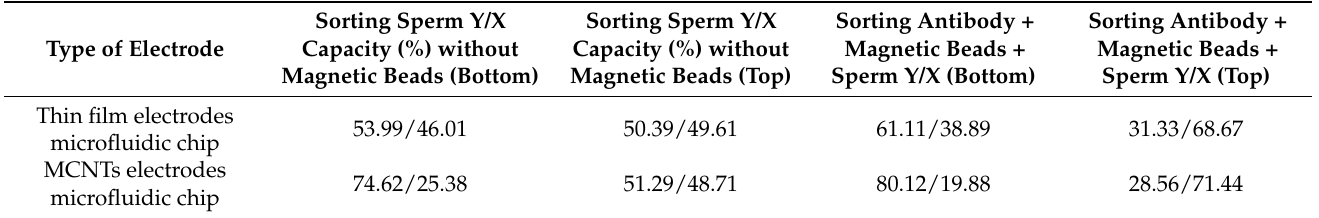
Figure 10. Flow of the magnetic particles on a monoclonal antibody and sperm in microstructure flow channel with microfluidic chip. Table 6. Efficiency results of X and Y sperm separation based on the measurement using real-time Polymerase chain reaction (PCR)